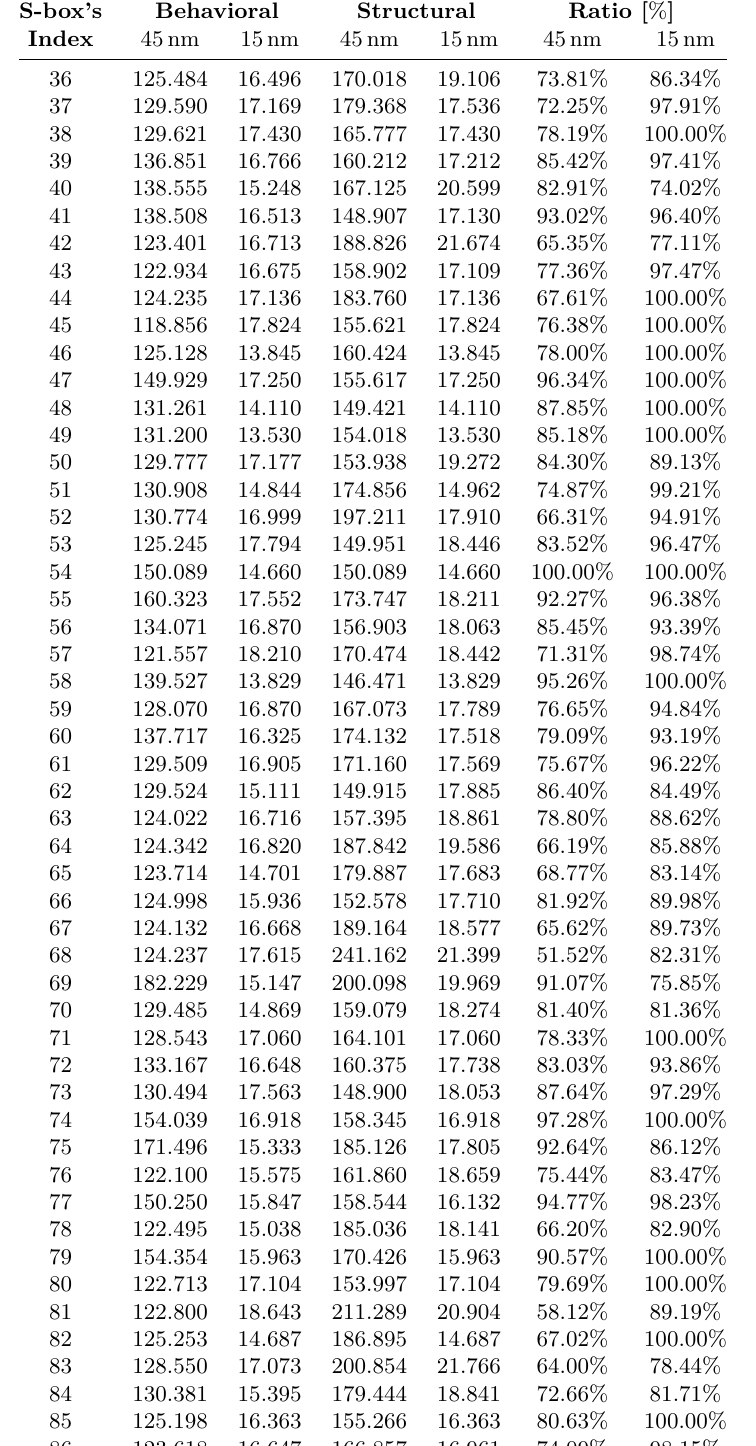
Table 8: Latency of the circuits for 7-bit quadratic S-boxes used in Example 5 using behavioral and structural modes of implementation in NanGate 15 nm and 45 nm